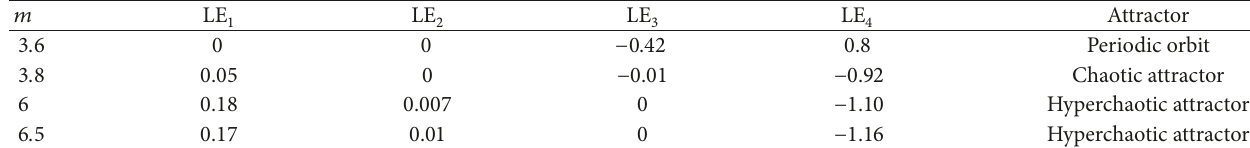
Table 2: The LEs of some typical attractors of system (1).